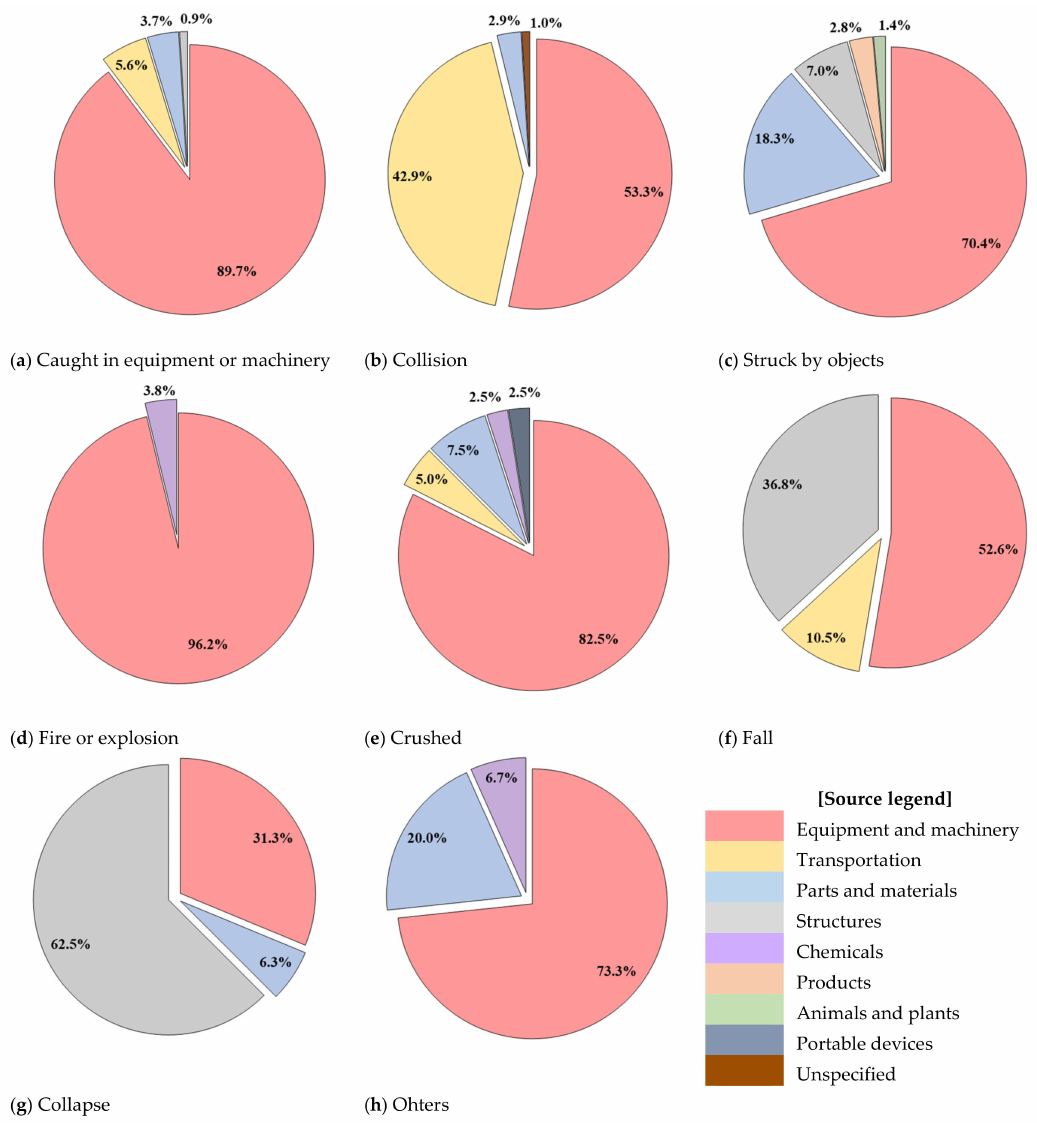
Figure 8. Distribution of sources of accidents caused by multiple processes in the